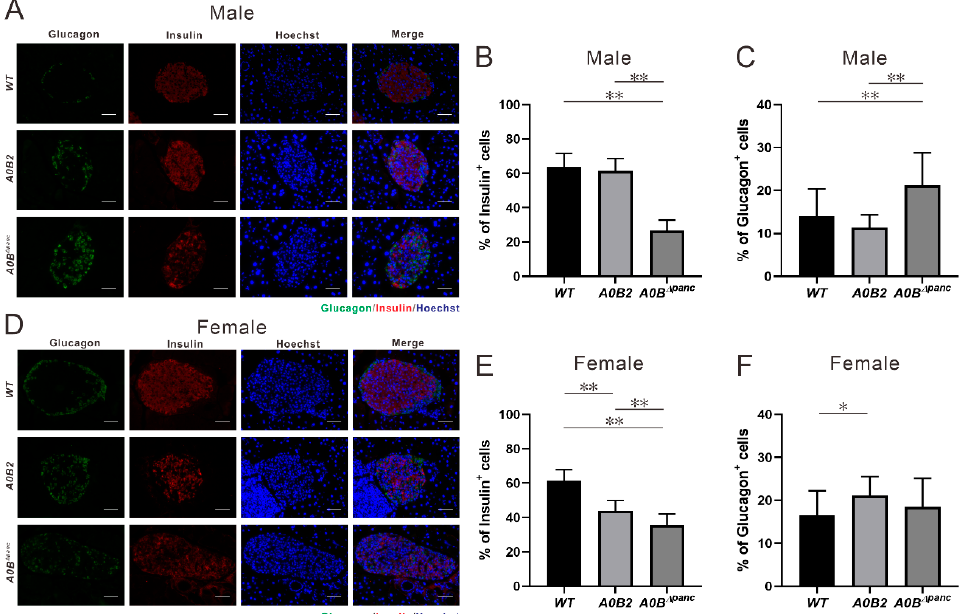
Figure 6. Immunohistochemistry analysis and specific hormone cell number counting, ( A – C , male; D – F , female). ( A , D ) Immuno-staining of glucagon (green) and insulin (red) in pancreatic islets from 16 weeks post-TAM injection in mice of each indicated genotype. ( B , E ) Insulin positive cell number/total islet cell number in pancreatic islets of each group. The results are from 15–25 islets of 2–3 mice in each genotype. ( C , F ) Glucagon positive cell number/total islet cell number in pancreatic islets of each group. * p < 0.05; ** p < 0.01, the error bars indicate SD. Scale bar, 50 μ m. In contrast, the amount of glucagon positive cells within the islets of A0B Δ panc mice were slightly